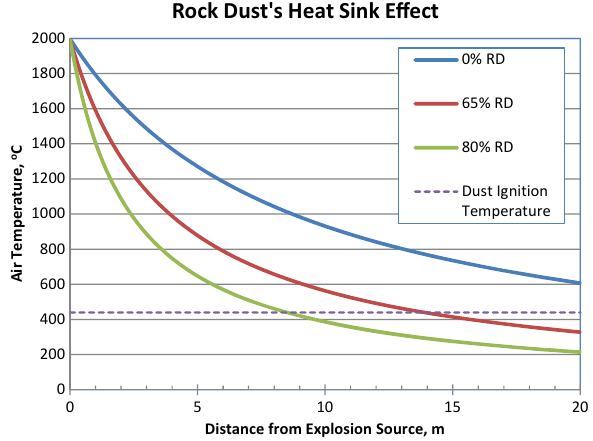
Fig. 3 Rock dust’s heat sink effect for lowering the mine air temperature